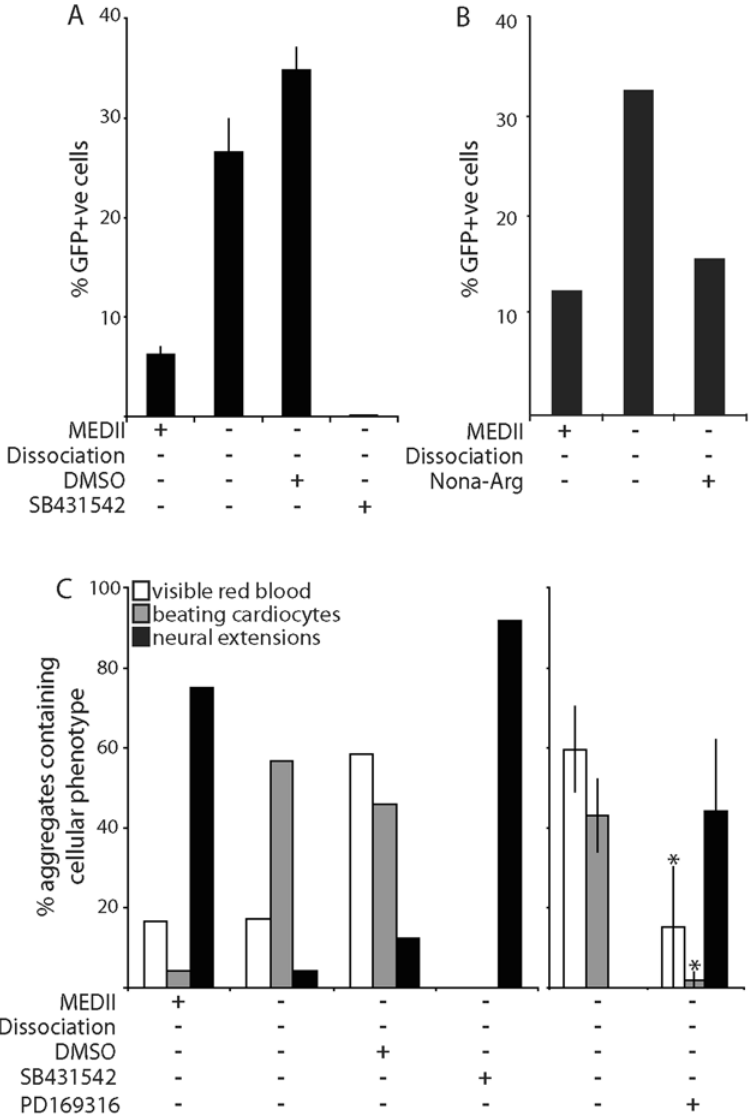
Figure 6. Tgf- b antagonists suppress mesoderm formation from EPL cells in culture. Mixl1:GFP ES cells were cultured as aggregates in MEDII for 3 days to form EPL cells. Aggregates were transferred to unsupplemented medium or medium supplemented with 50% MEDII, 0.4% DMSO or 10 m M SB431542 (prepared in DMSO) and cultured for a further 2 days before reduction to a single cell suspension. The proportion of GFP + cells present was determined by flow cytometry. n=3 independent experiments. Error bars represent standard error of the mean. (B). EPL cells were prepared as for (A) and transferred to unsupplemented medium or medium supplemented with 50% MEDII or 77 m M Nona-Arg (prepared in H 2 0) and cultured for a further 2 days before reduction to a single cell suspension. The proportion of GFP + cells present was determined by flow cytometry. A representative result is shown. (C). EPL cell aggregates were formed from ES cells and transferred to unsupplemented medium or medium supplemented with MEDII, DMSO, 10 m M SB431542 or 10 m M PD169316 as indicated. Aggregates were maintained in culture for a further 4 days before seeding them individually into 48 tissue culture wells and allowing them to differentiate. Aggregates were scored for the presence of visible red blood cells, beating cardiocytes and neural extensions and the peak score for each represented. n=3 independent experiments (PD169316). Error bars represent sem. A representative experiment is shown for SB431542.